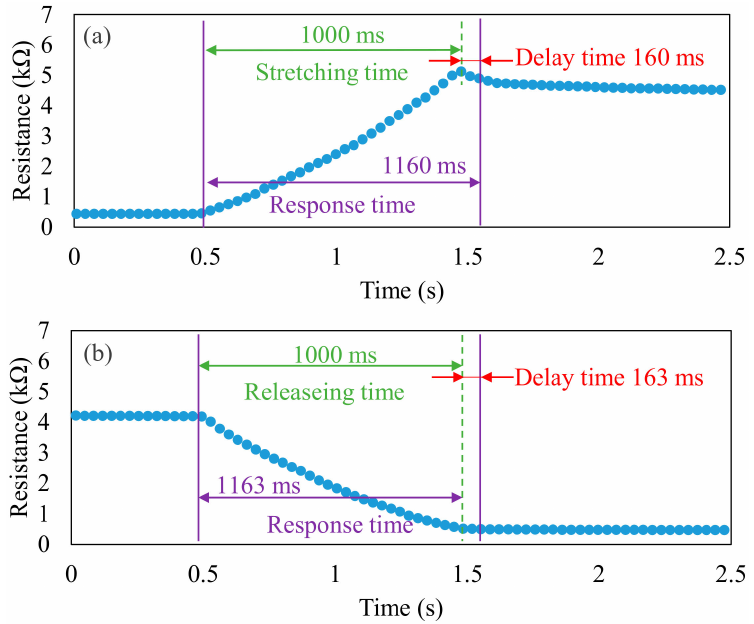
Figure 13. Response and delay times of the LIG strain sensor under an applied strain for ( a ) stretching and ( b ) releasing.